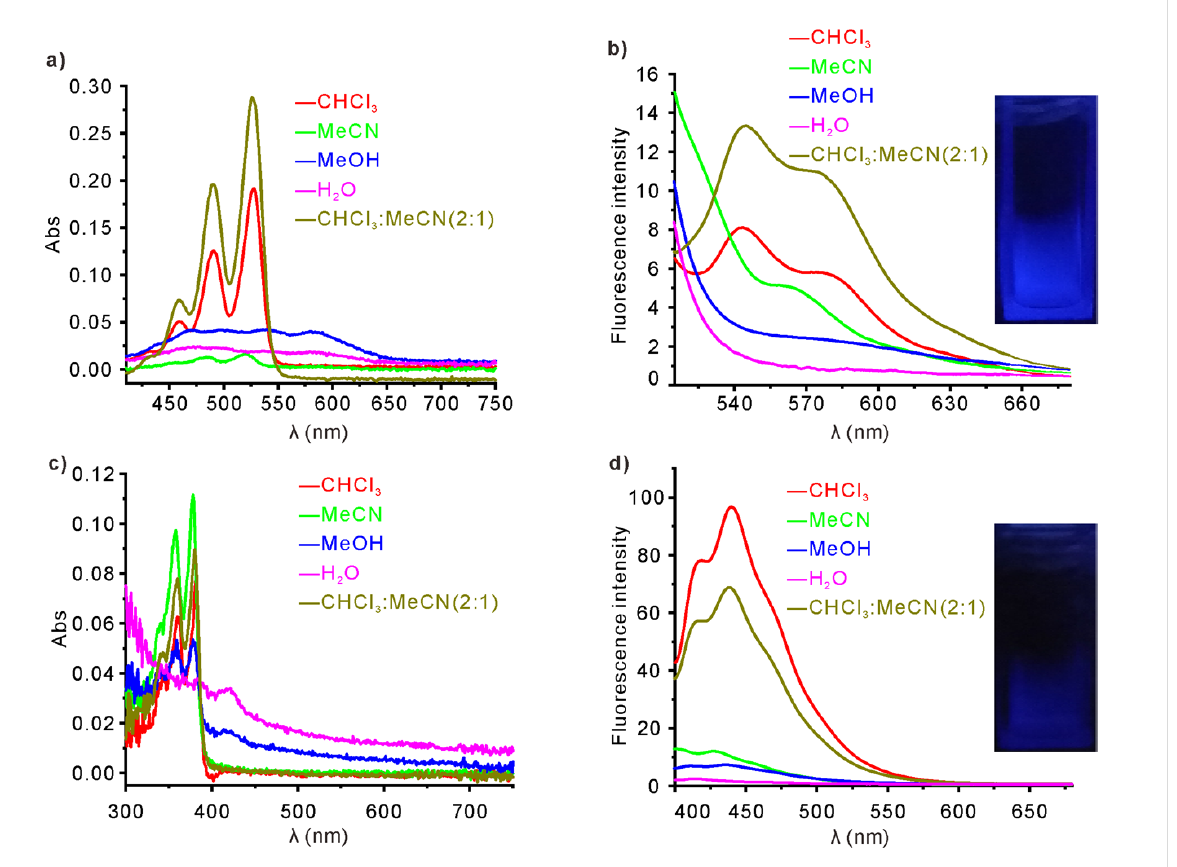
Figure 1: (a) UV–vis absorption spectra and (b) fluorescence spectra ( λ ex = 490 nm) of 1 in different solvents (inset: photograph of 1 in CHCl 3 irradi- ated under 365 nm); (c) UV–vis absorption spectra and (d) fluorescence spectra ( λ ex = 360 nm) of 2 in different solvents (inset: photograph of 2 in CHCl 3 irradiated under 365 nm). The concentration of 1 or 2 in the solutions is 5.0 × 10 − 6 M. All the measurements were performed at room tempera-